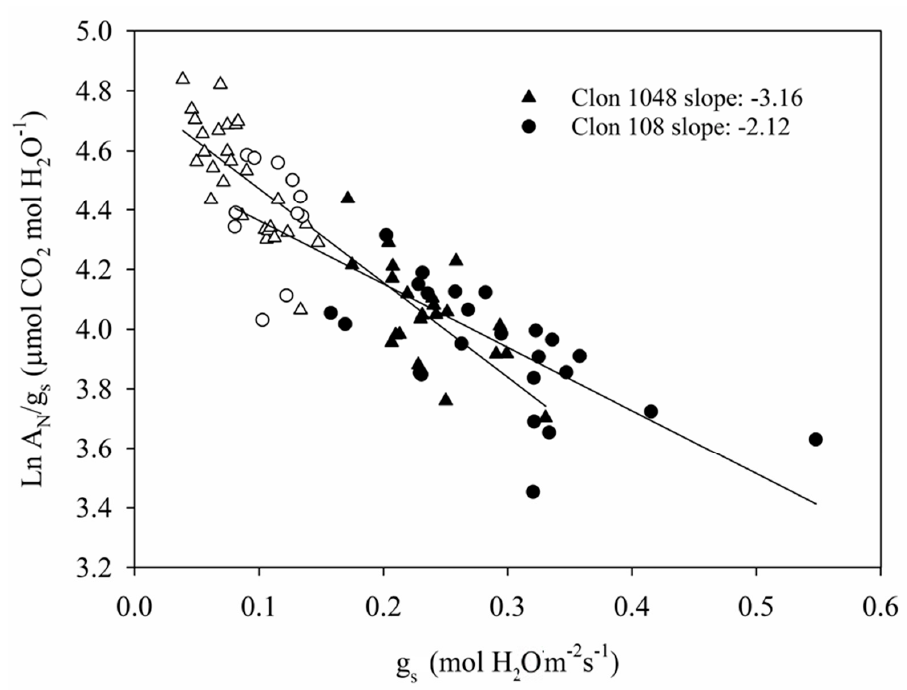
Figure 6. An example of the relationship linearized regressions between WUE i and g s using the natural logarithm of WUEi of two contrasting clones. Filled symbols correspond to well-watered conditions; empty symbols correspond to moderate water stress conditions. Table 3. The relative position of WUE i predicted for each genotype linear regression at di ff erent g s. The maximal, minimal, and the mean value of all genotypes were including in µ mol CO 2 mol − 1 H 2